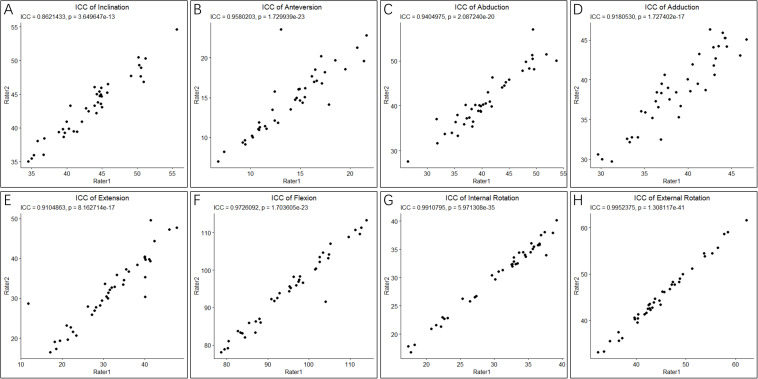
Intraclass correlation coefficients of cup orientation and hip ranges of motion (HROMs). The ICC score of two parameters of cup positioning, inclination (A) and anteversion (B), and six parameters of HROMs, abduction (C), adduction (D), extension (E), flexion (F), internal rotation (G), and external rotation (H), were bigger than 0.8 with p-value < 0.05, suggesting that the measurements were reliable.